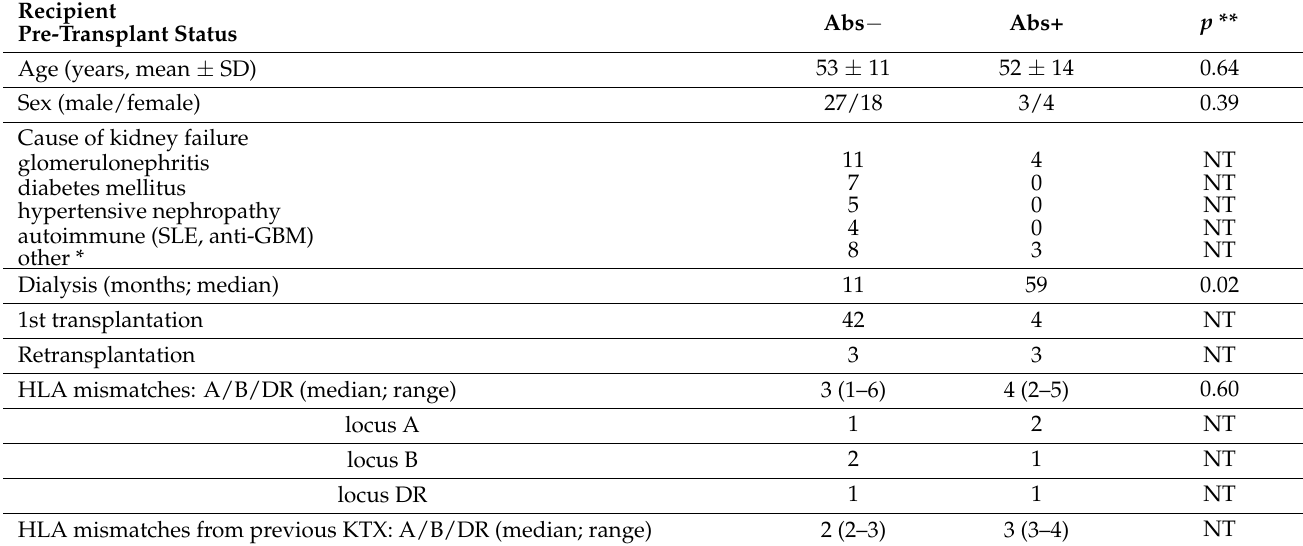
Table 1. Pre-transplant patient’s